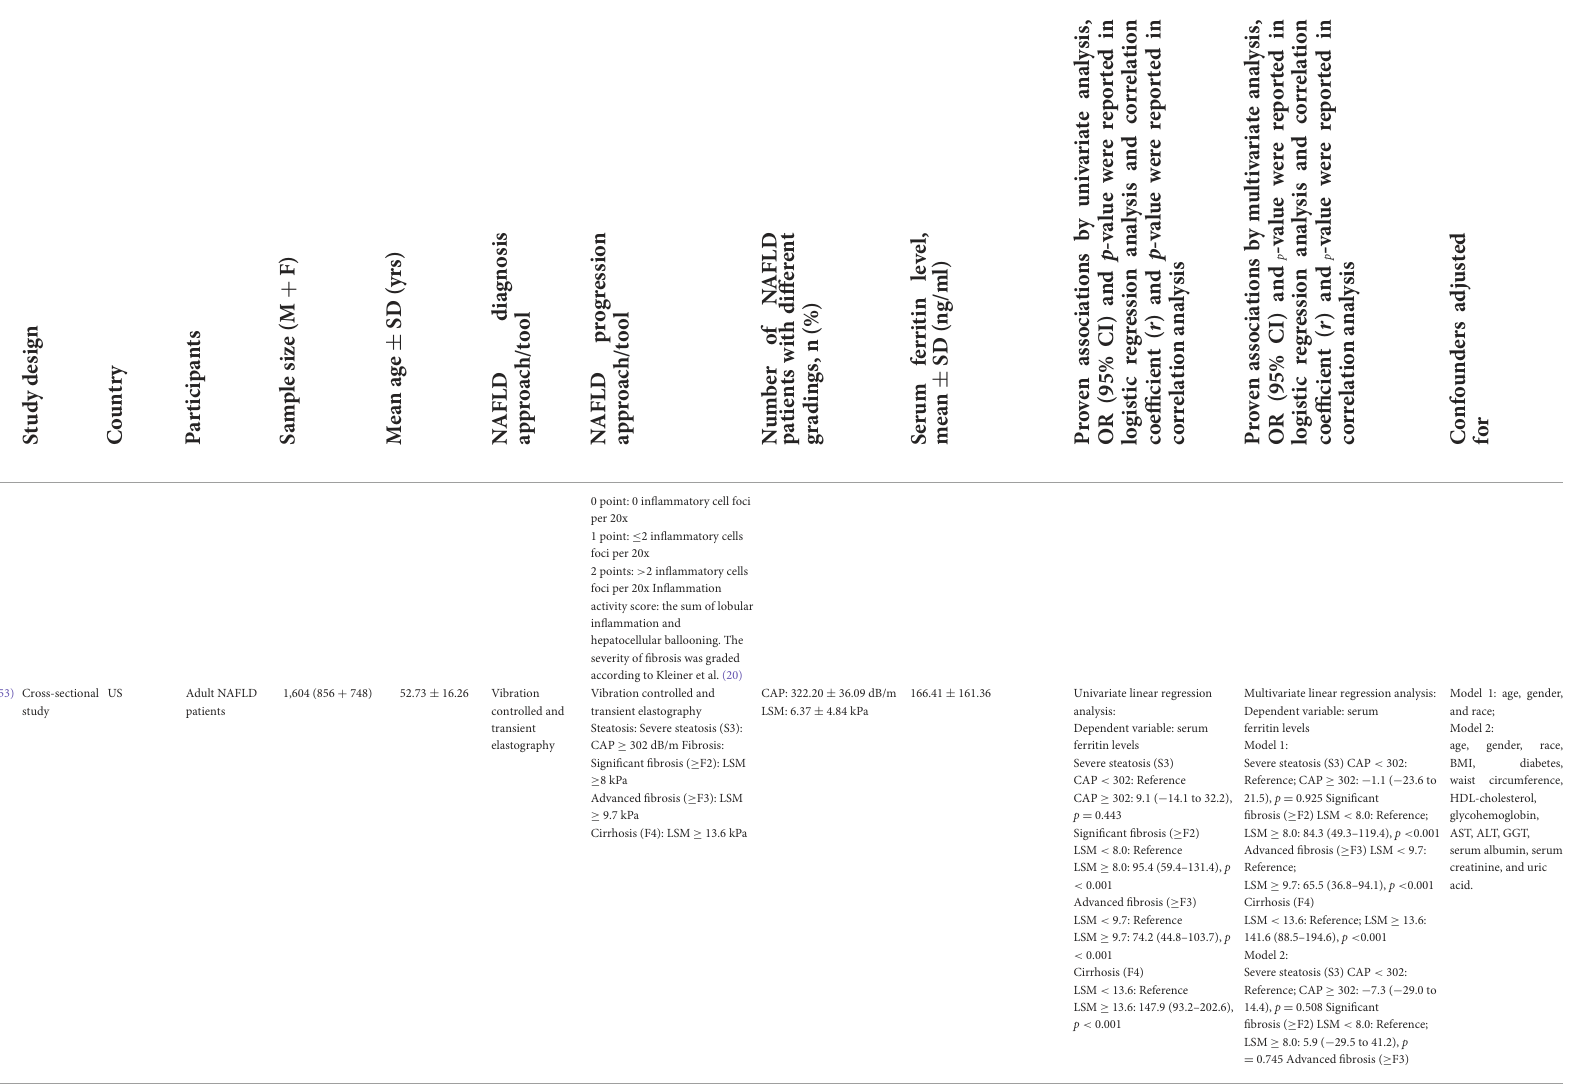
Univariatelinearregression analysis: Dependentvariable:serum ferritinlevels